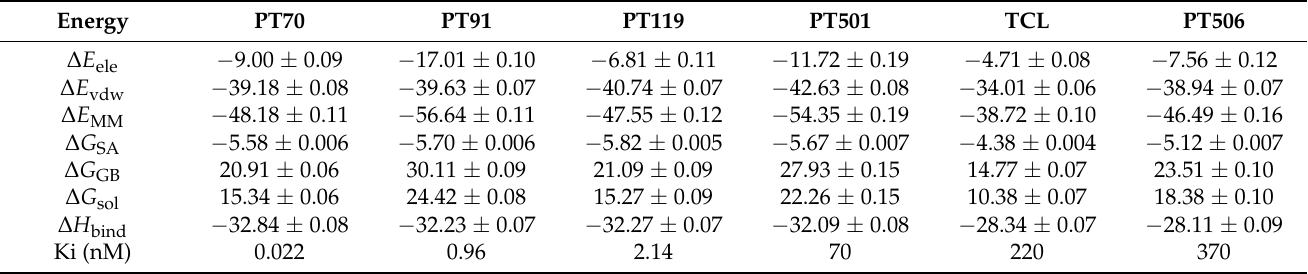
Table 1. The binding free energy and the contribution of different energy terms (kcal/mol).